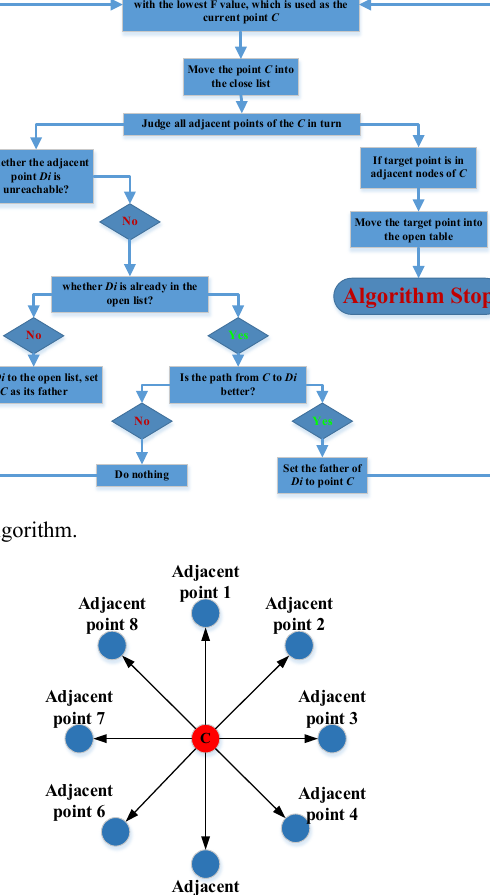
Fig. 4. Omnidirectional node